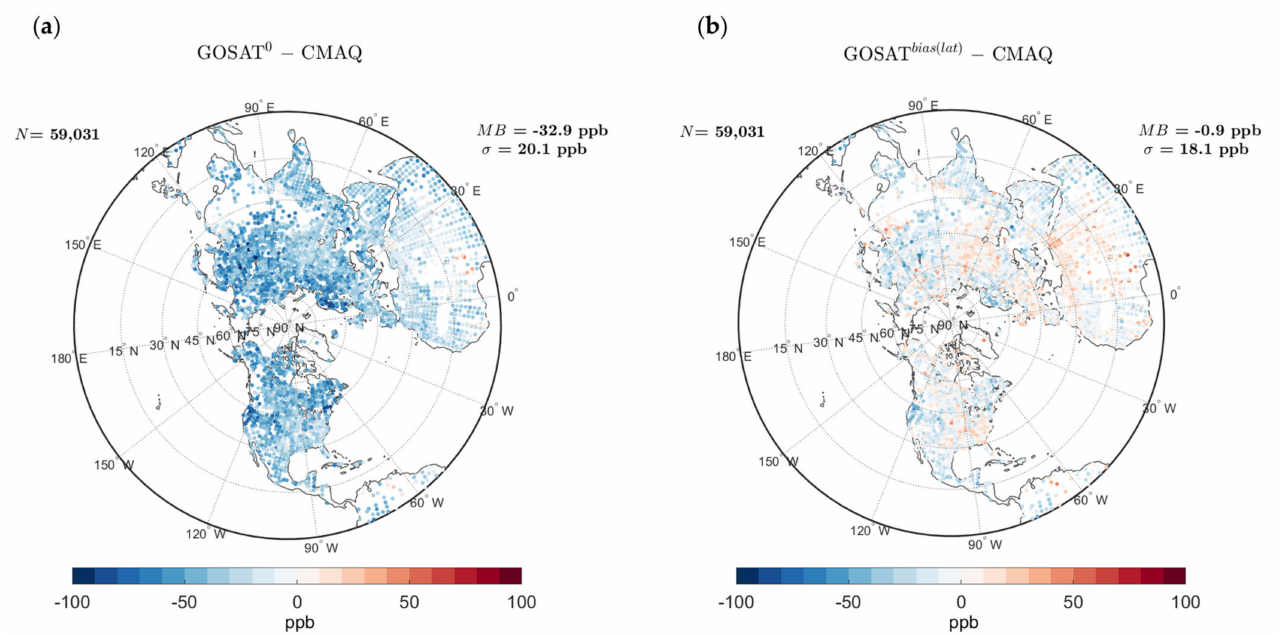
Figure 5. ( a ) Difference between observations and model before bias correction (GOSAT 0 —CMAQ) and ( b ) after bias correction with respect to latitude (GOSAT bias(lat) —CMAQ) over a month with the number of observations N = 59,031. A bias-corrected field of residuals calculated from the regression with respect to AMF and θ s is provided in Figure